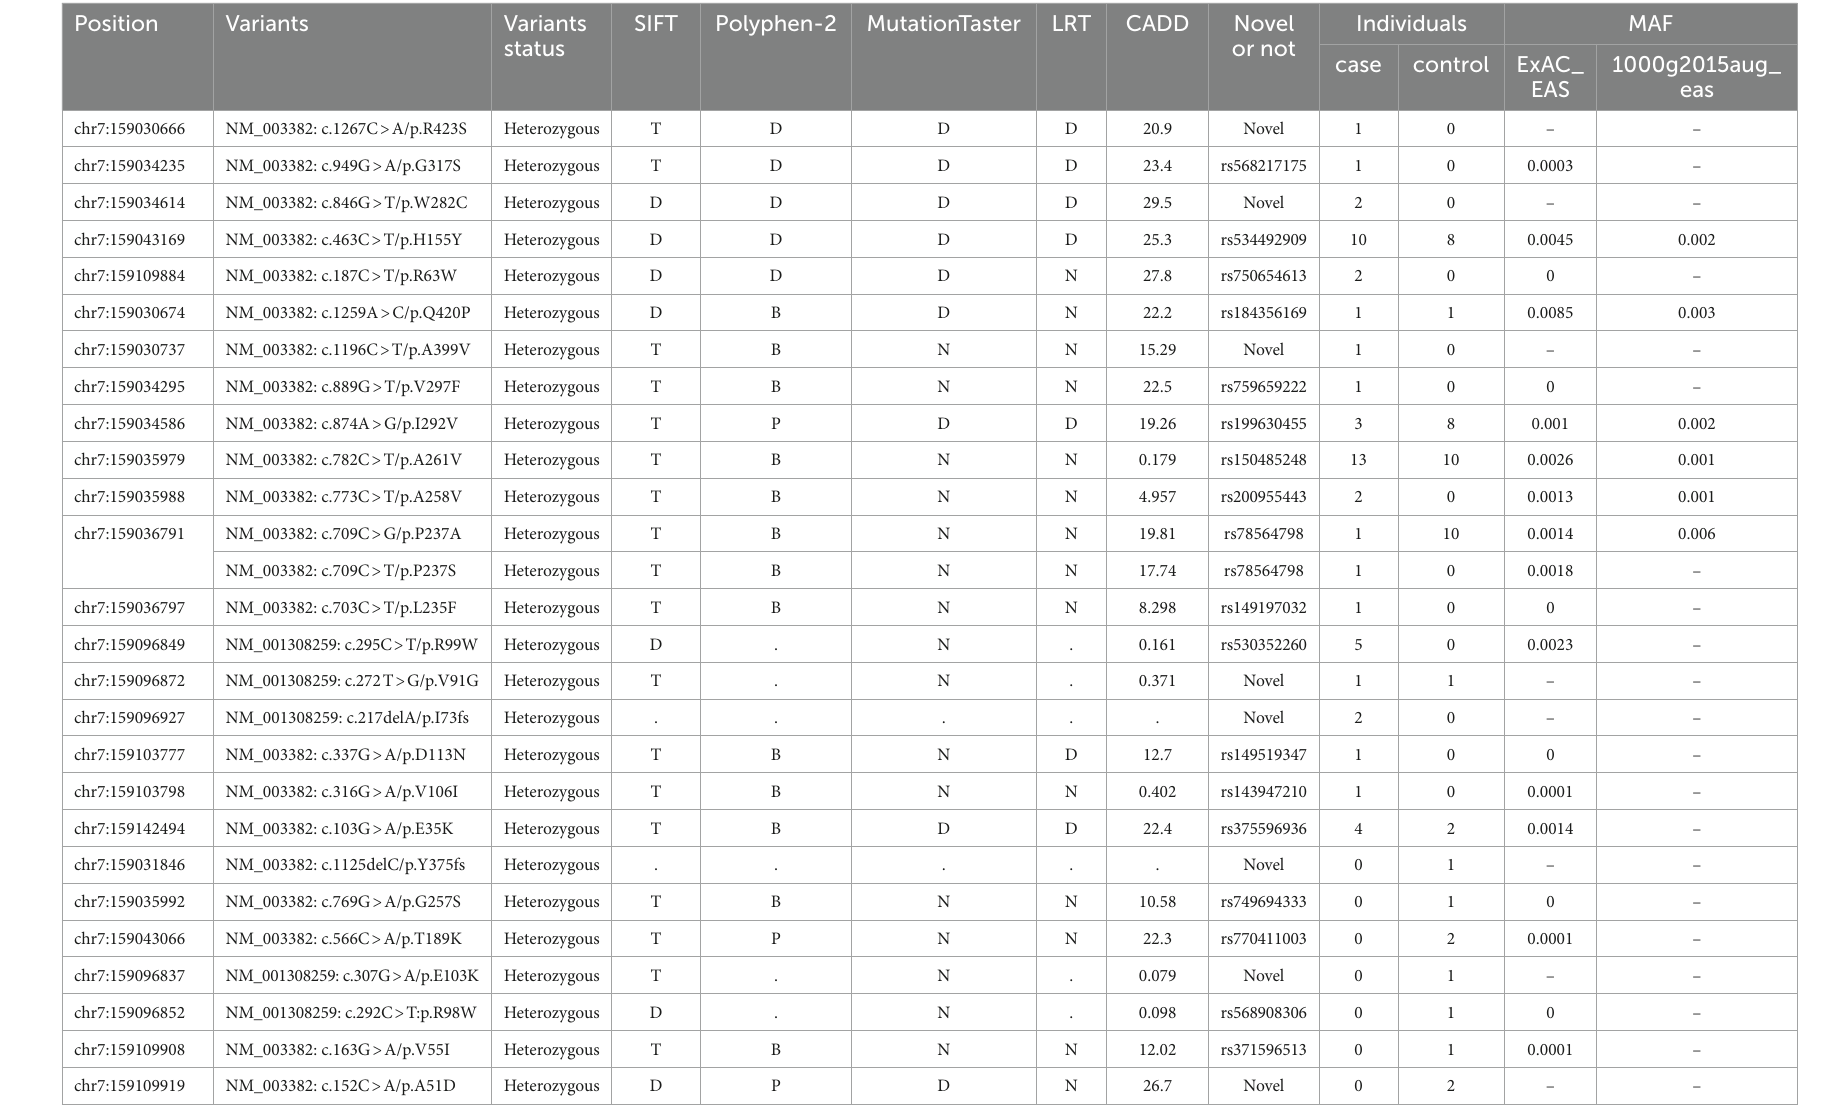
TABLE 2 Detailed information on rare functional variants detected in this